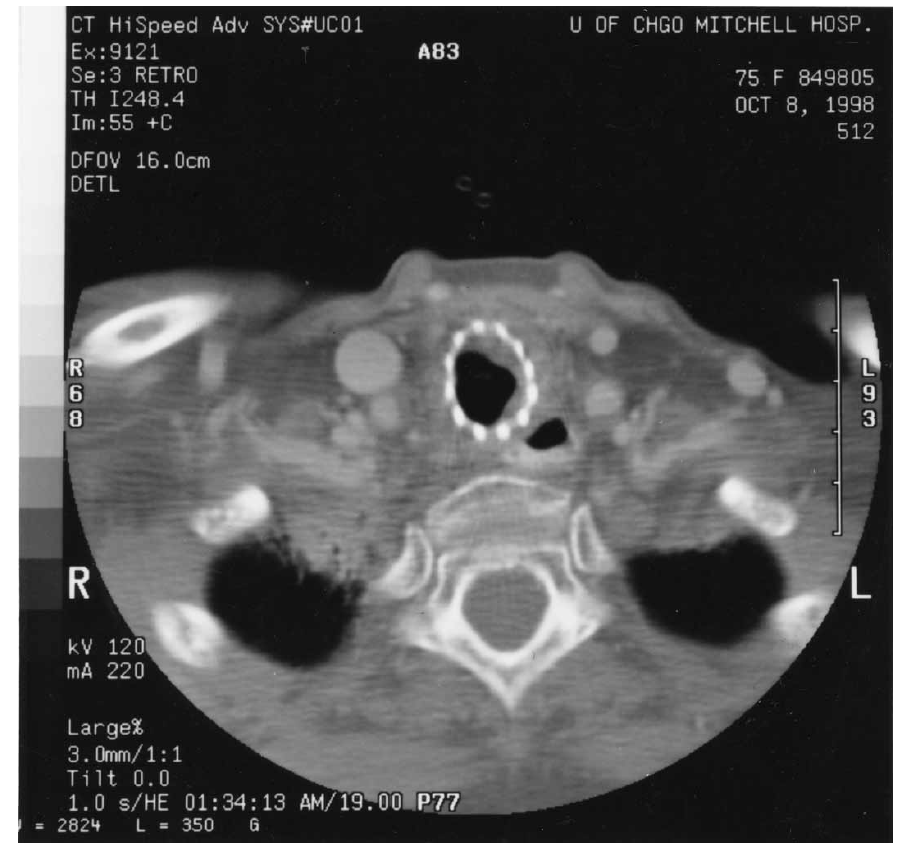
Fig. 3. CT of neck with intravenous contrast shows tracheal mass growing through tracheal ring stent.